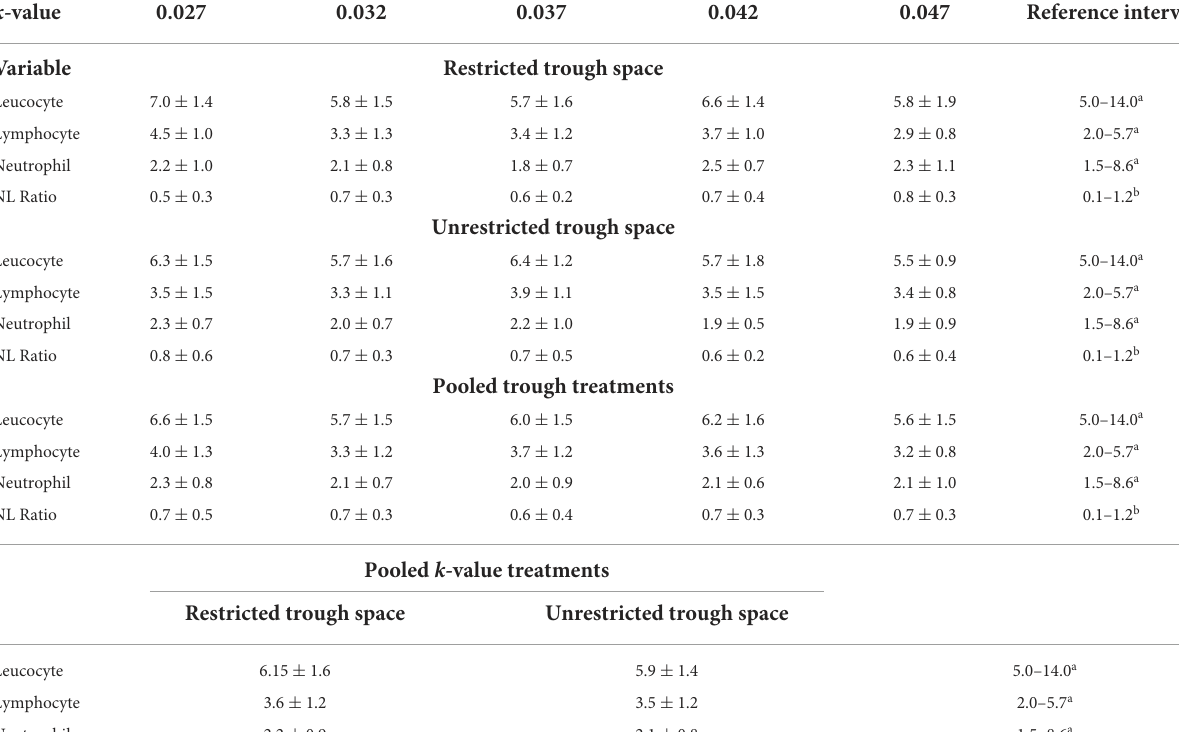
TABLE 8 Day 18 leucocyte, lymphocyte, and neutrophil counts ( × 10 6 cells/ml) and day 18 neutrophil to lymphocyte ratios (NL ratio) expressed as means and standard